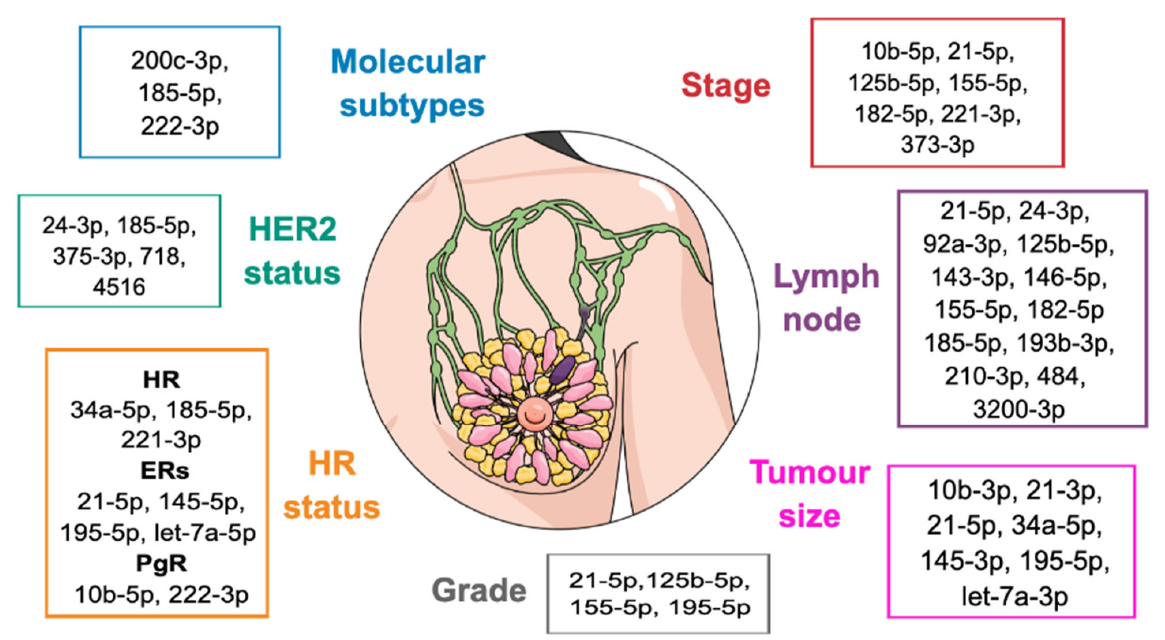
Figure 1. Circulating miRNAs significantly associated with BC clinical ‐ pathological features.